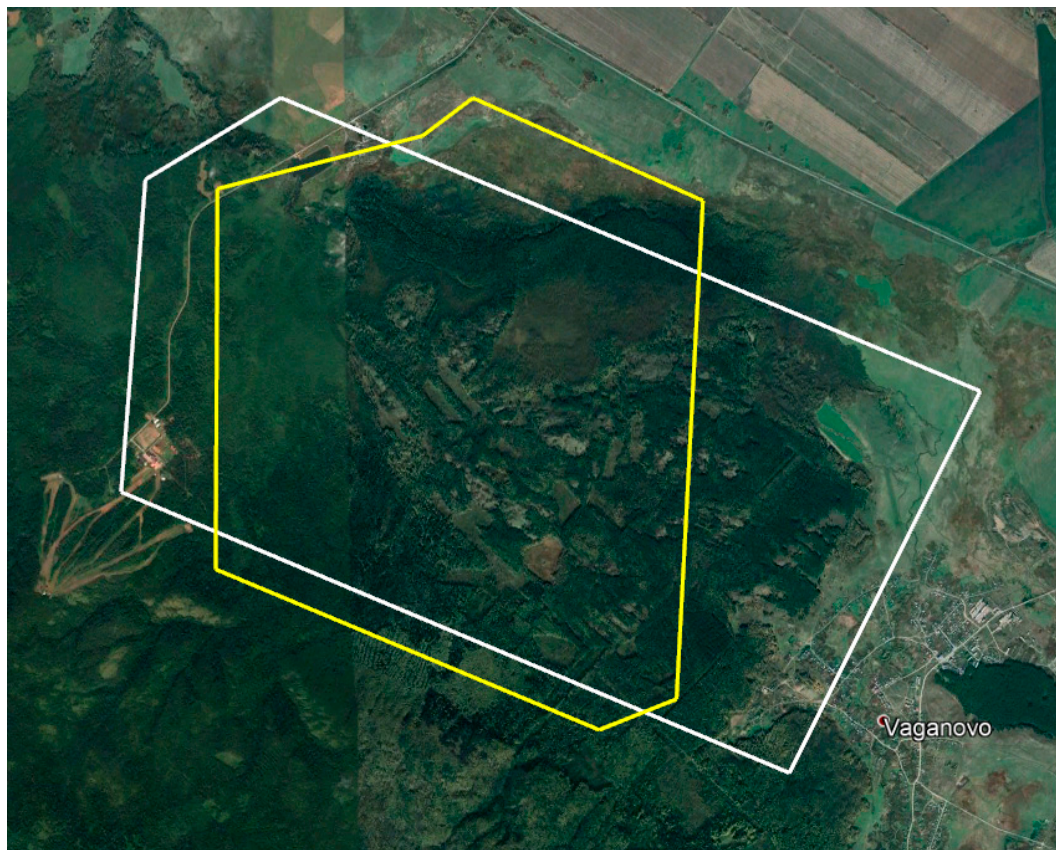
Figure 4. The boundaries of the territories surveyed in 2019 and 2020. The survey of 2020 revealed 63 objects, of which 55 were elks. Figure 5 shows their spatial distribution.